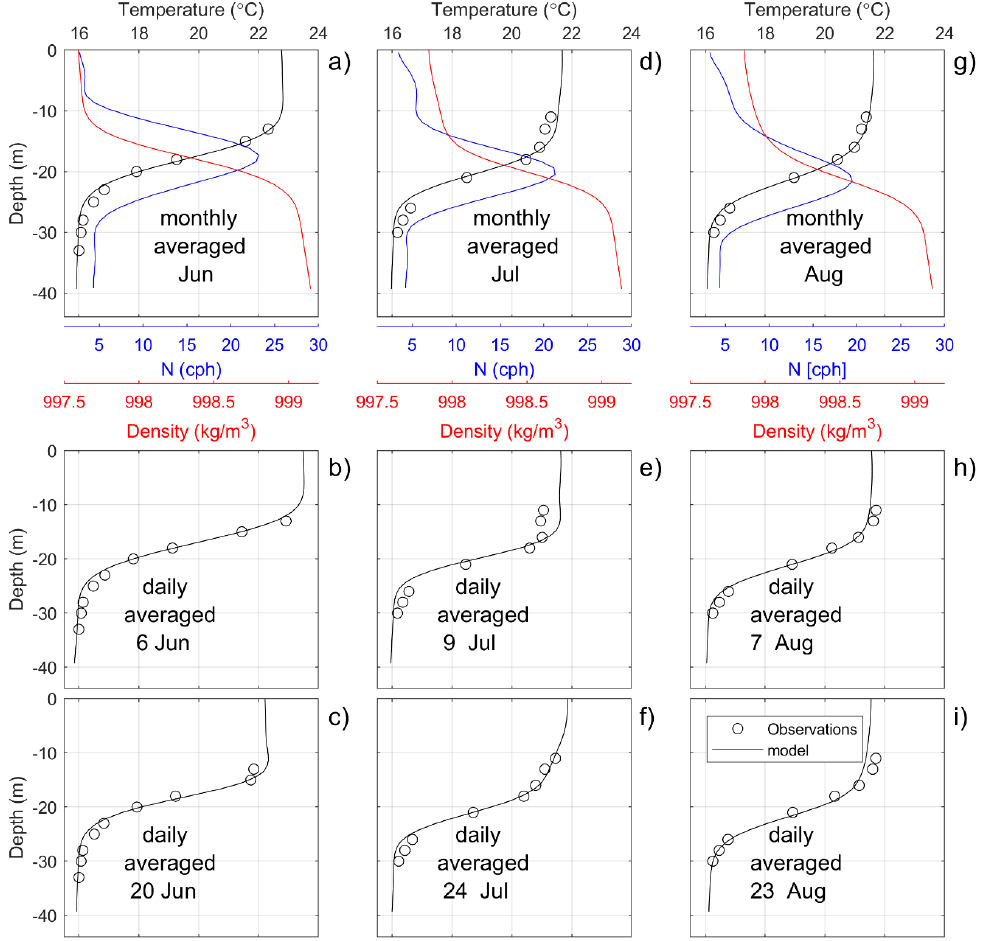
Figure 16. Monthly and daily changes in the vertical distribution of water temperature (black line), water density (red line) and buoyancy estimated from the Brunt–Väisälä frequency N (blue line). In ( a , d , g ) are the monthly means, in ( b , c ) temperature for particular days for June, ( e , f ) for July and ( h , i ) for August. Measured values are open circles and predicted values using the numerical model are solids lines.